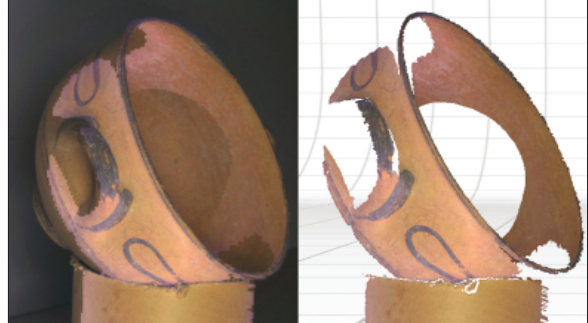
Figure 8. Single textured scan (right); the matching picture taken by the scanner’s camera (left)